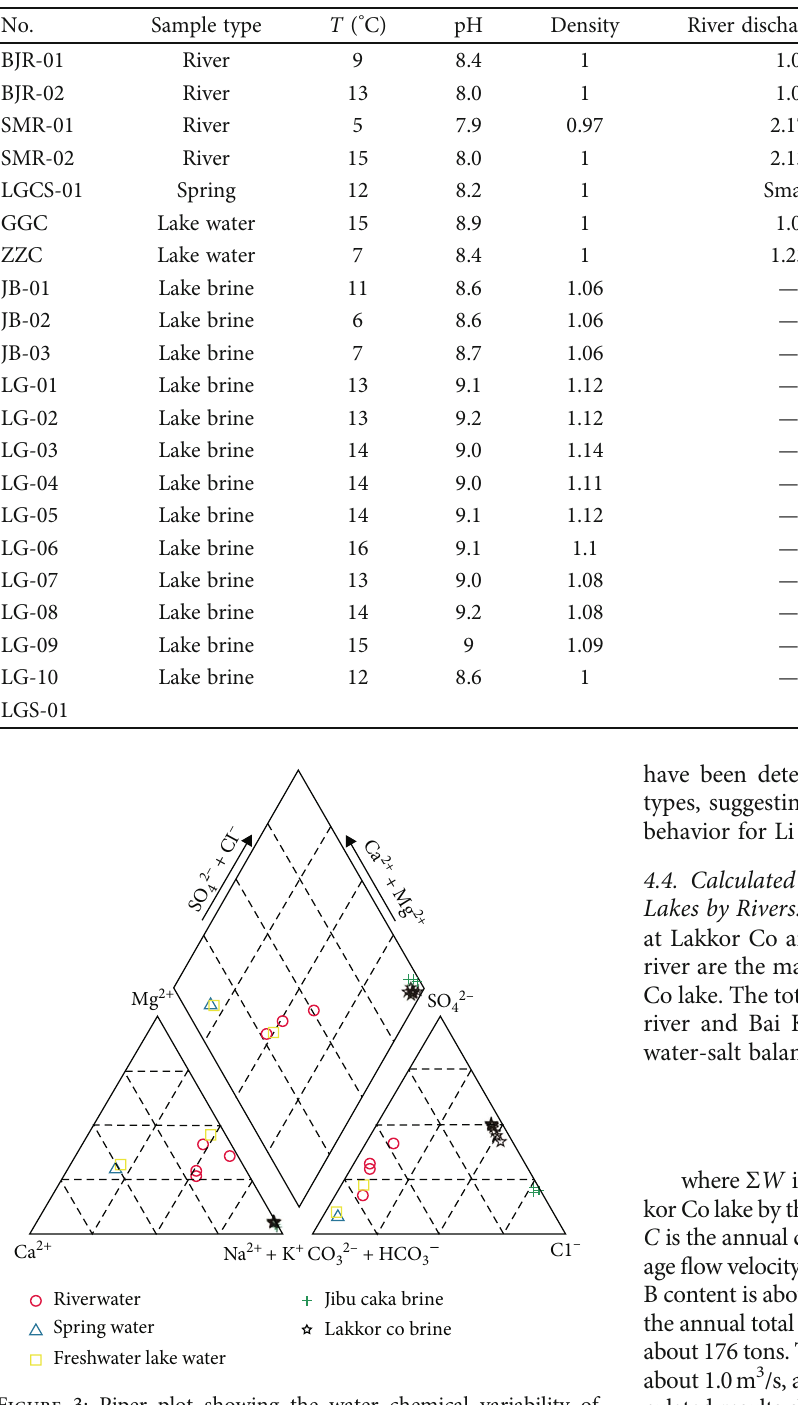
Figure 3: Piper plot showing the water chemical variability of Lakkor Co